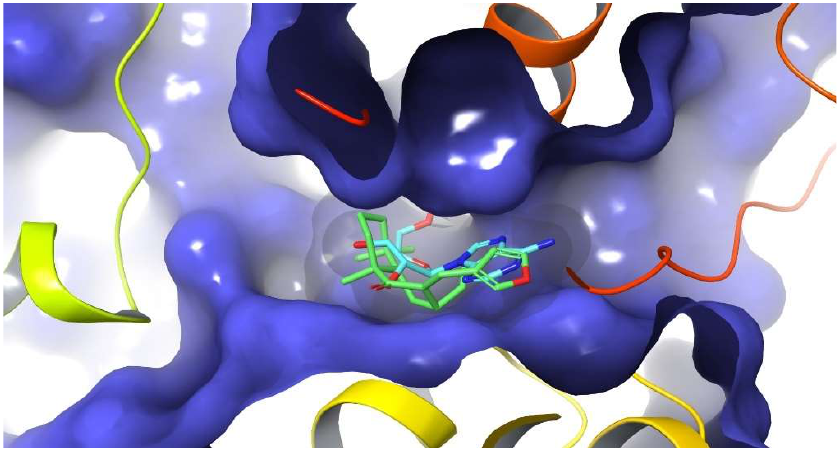
Figure 8. Covalent Docking of DIH occupying a large part of the ATP binding site (PDB 7ALV).